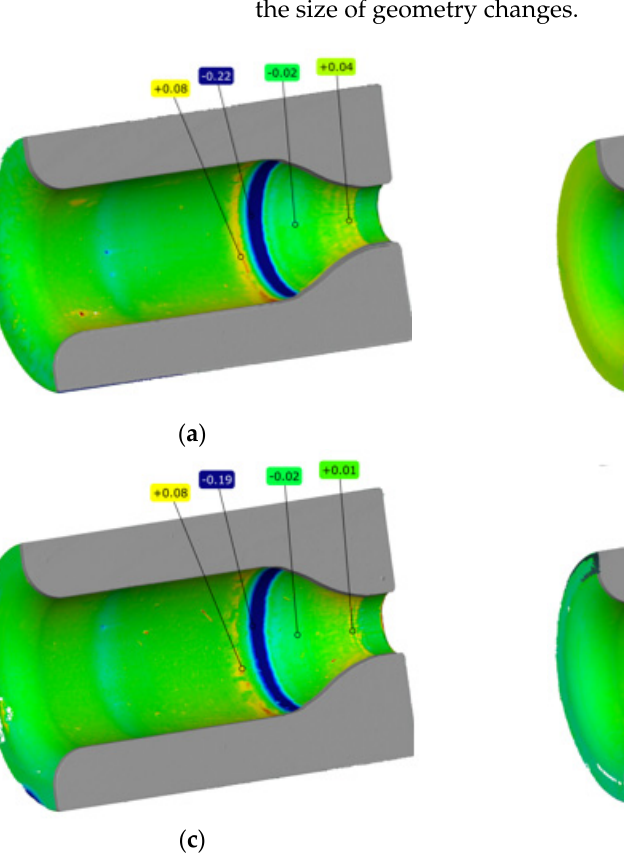
Figure 10. Results of 3D scanning of dies cut in half: ( a ) variant 1; ( b ) variant 2; ( c ) variant 3; ( d ) variant 4.